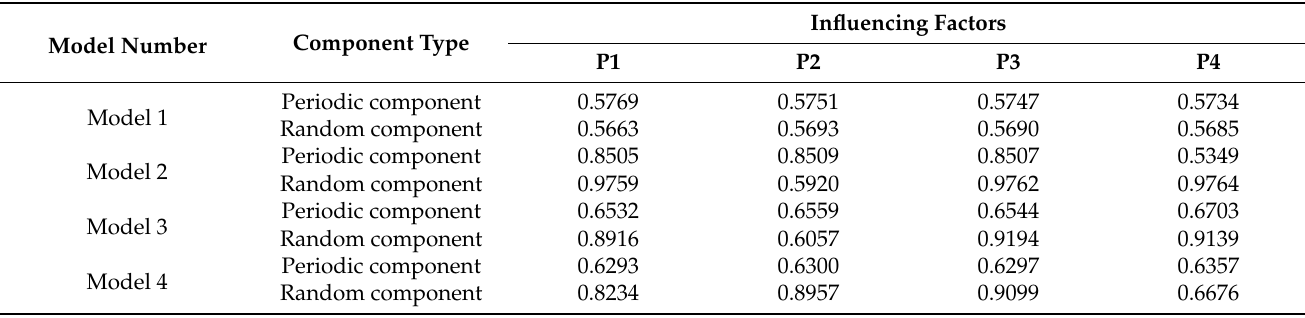
Table 2. Analysis of the relational degree between the displacement component and the influence factor